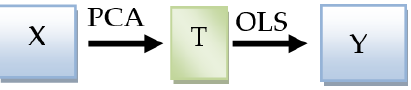
Figure 5. General representation of PCR model.